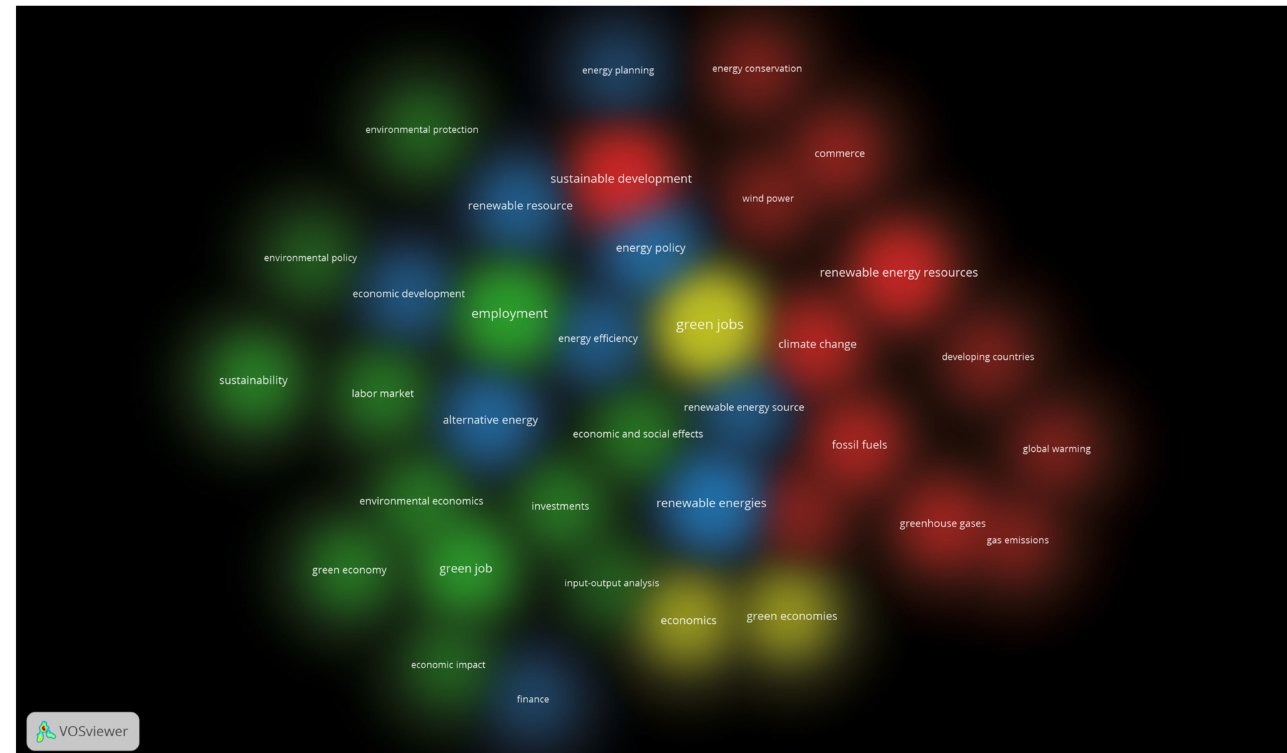
Figure 6. Cluster density visualization. Source: Authors’ elaboration in VOSviewer software (1.6.18